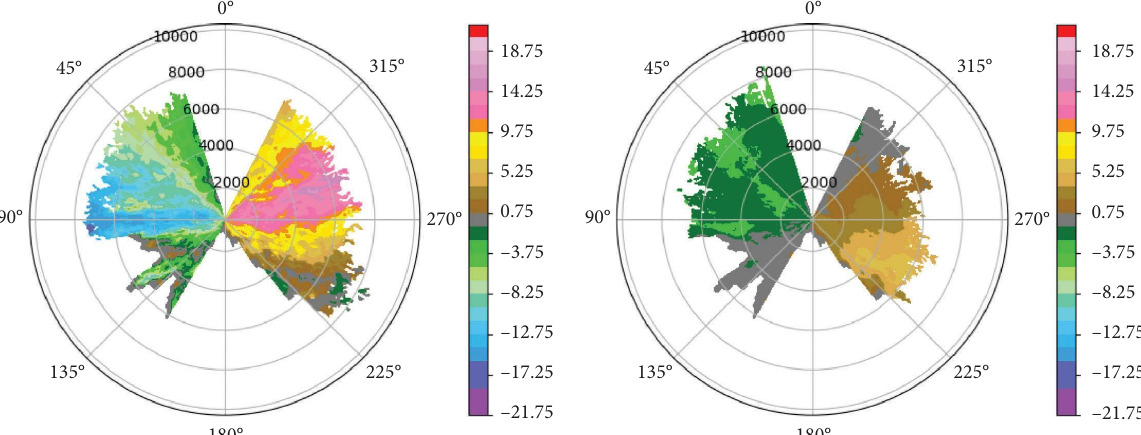
Figure 1: LiDAR radial velocity (knots) images collected at HKIA in PPI mode with 3 ° elevation and 350 − 10 , 000m slant ranges, where positive radial velocities (brown/yellow/orange/pink) are away from LiDAR and negative radial velocities (green/blue/purple) are toward the LiDAR. Each scan takes about 20–30 seconds. 400–500 beams are emitted to obtain one scan. Due to the complex terrain near HKIA, data with good quality are not available at a high slant range (blank